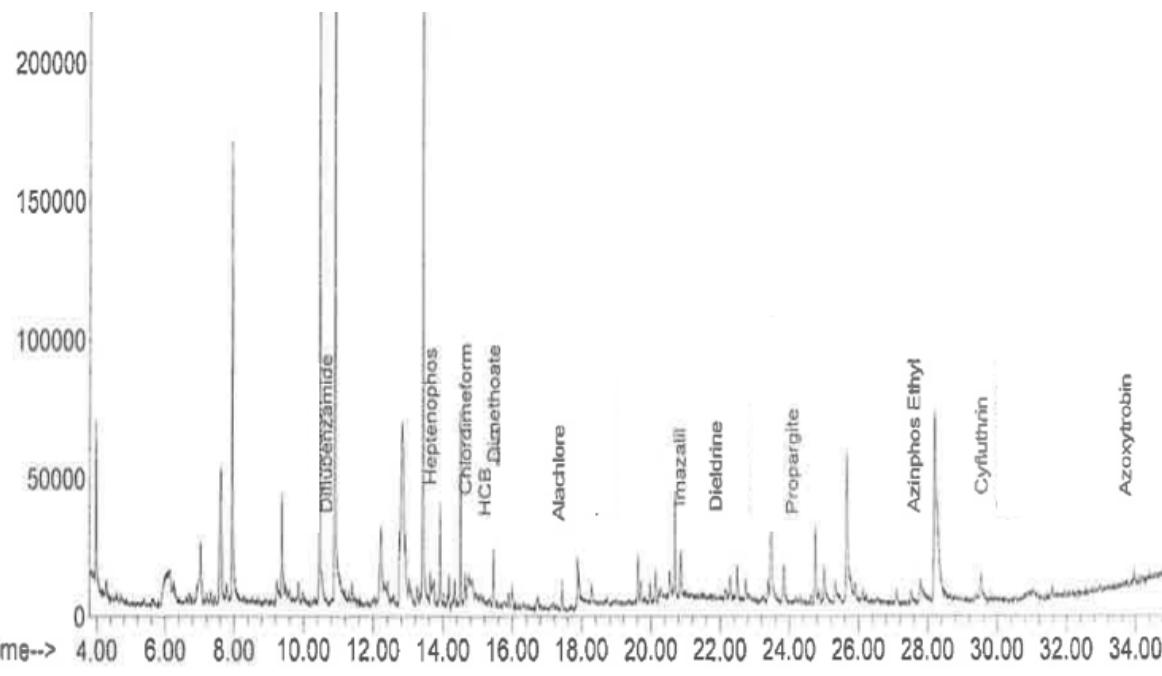
Figure 3. Chromatogram of samples in pesticide residues (G197).